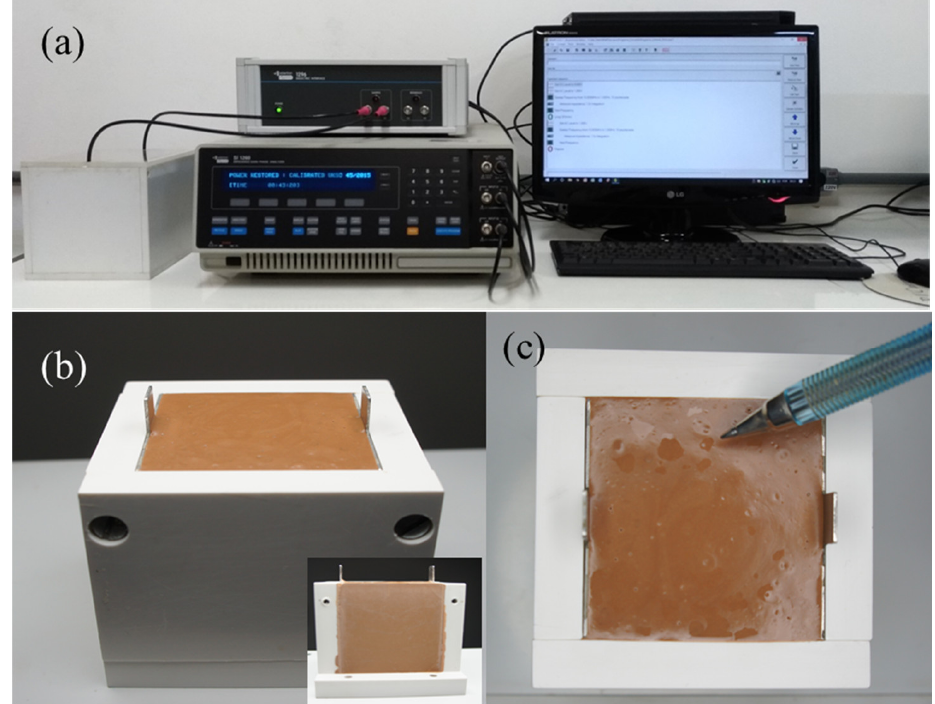
Figure 3. ( a ) Experimental equipment used to perform the impedance tests. ( b ) Image of the electrode systems. Inset: highlights the open mold on the side, illustrating the adhesion of the geopolymer to the electrodes. ( c ) Image of the surface of the MK sample with an emphasis on water expelled to the surface after 2 days.